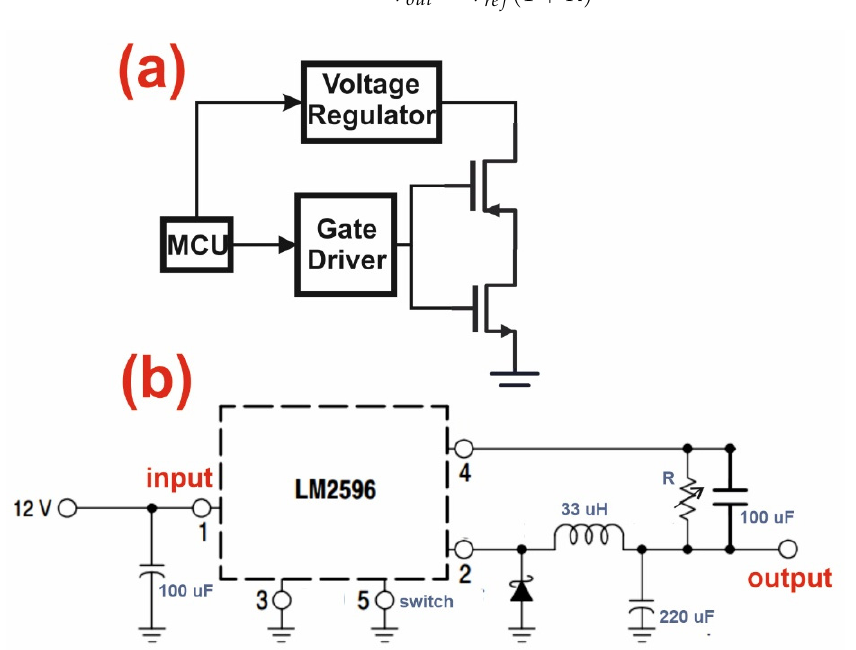
Figure 5. ( a ) Schematic of Class D amplifier. ( b ) Circuit designed to run the LM2596